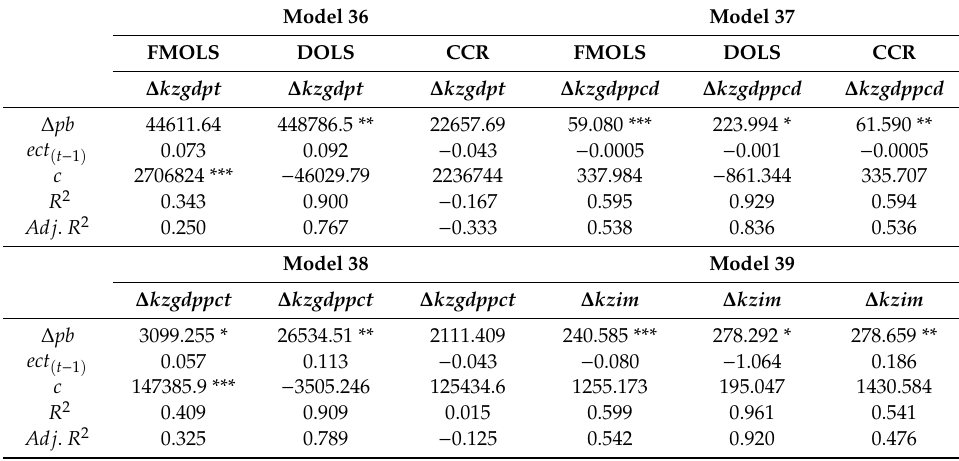
Table 17. The influence of oil price on macroeconomic indicators